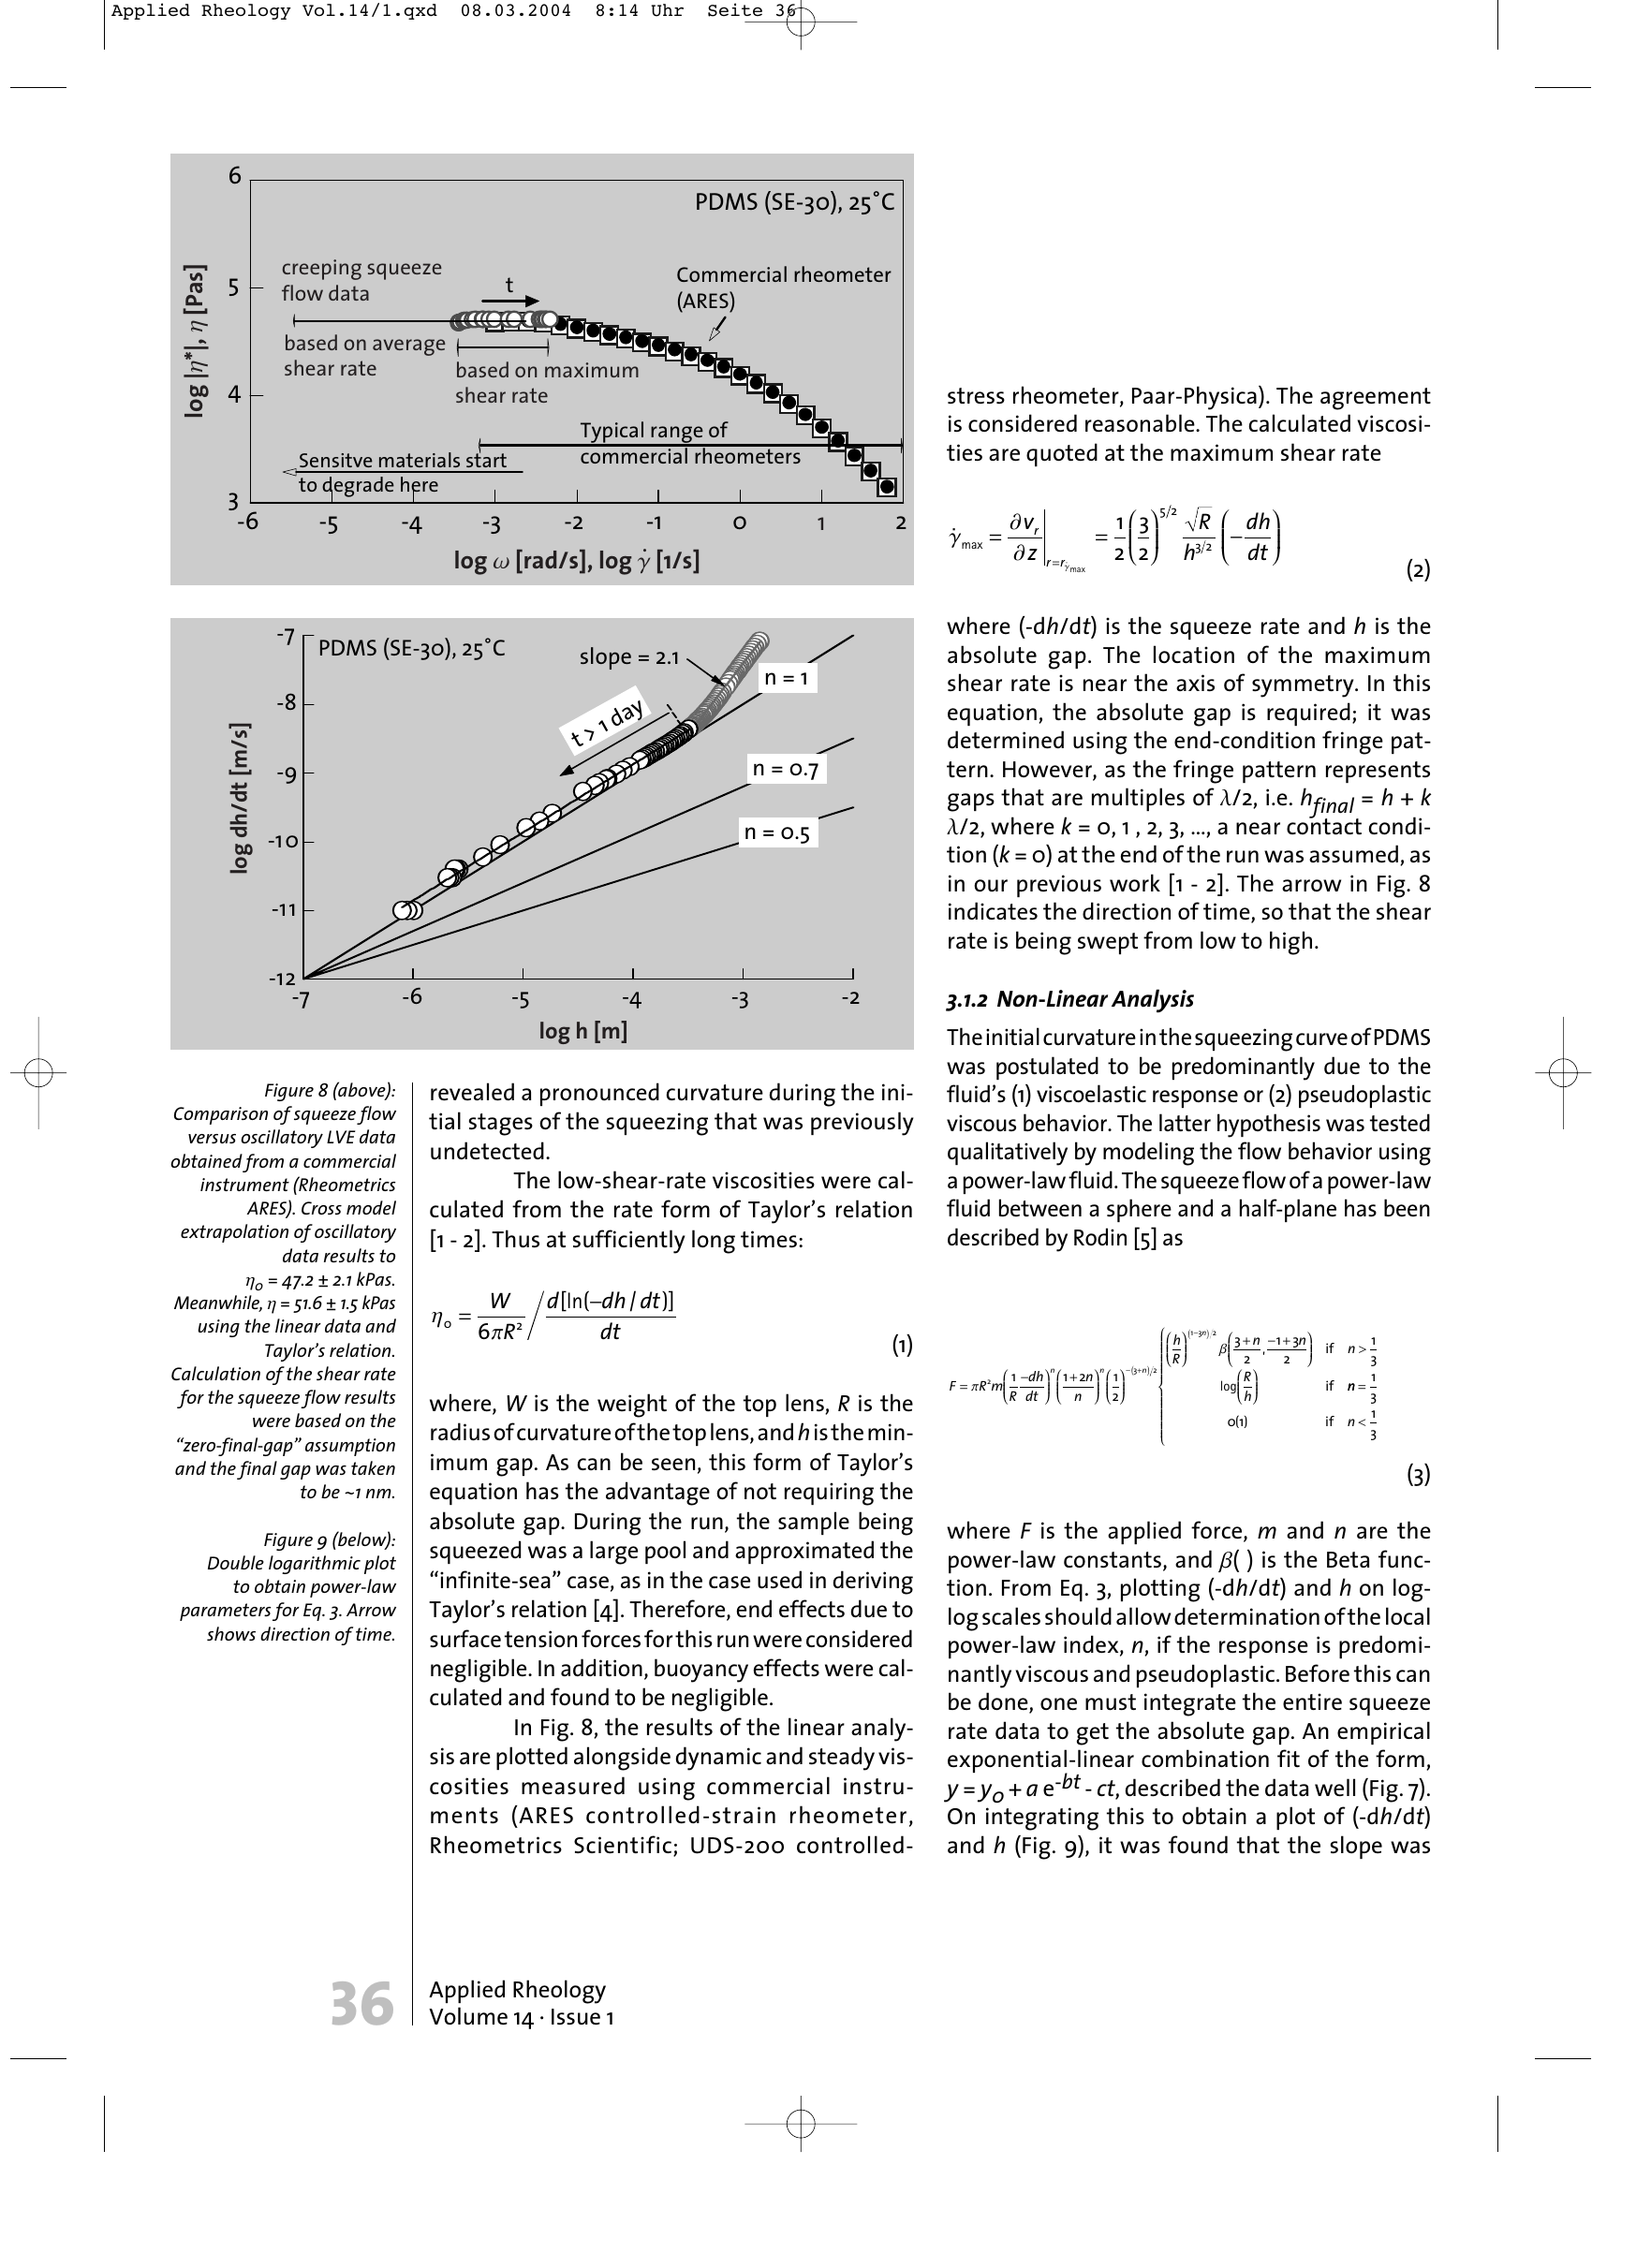
Figure 9 (below): Double logarithmic plot to obtain power-law parameters for Eq. 3. Arrow shows direction of